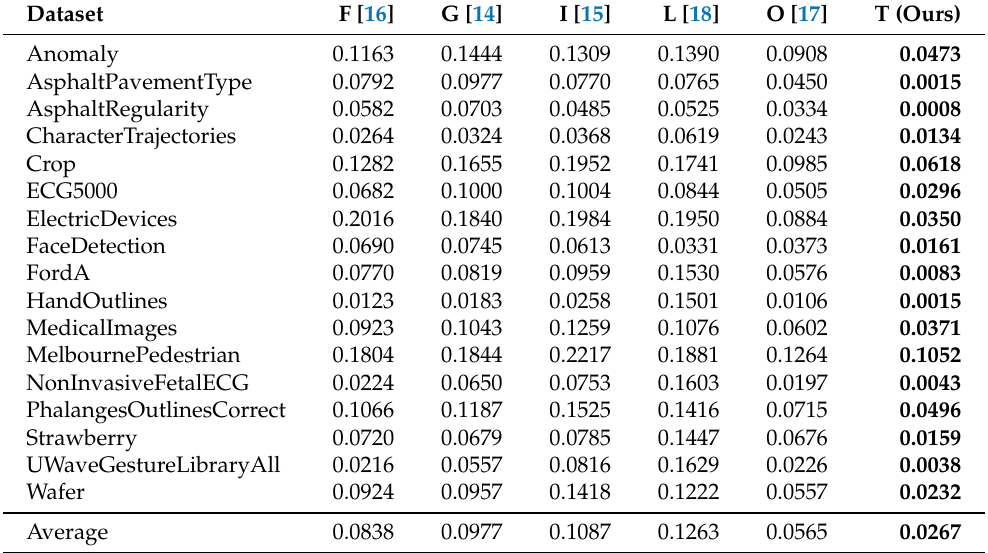
Table 6. Continuity. Lower values correspond to better performance. The method names are shortened by taking only the initial character (FeatureAblation, Guided-Backpropagation, Integrat- edGradients, LIME, Occlusion, TimeREISE). TimeREISE shows a superior performance across all datasets. Best results are highlighted in